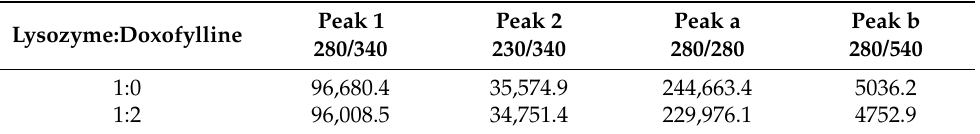
Table 2. Excitation-emission peak values for the interaction of doxofylline with lysozyme obtained by 3D-fluorescence spectroscopy.